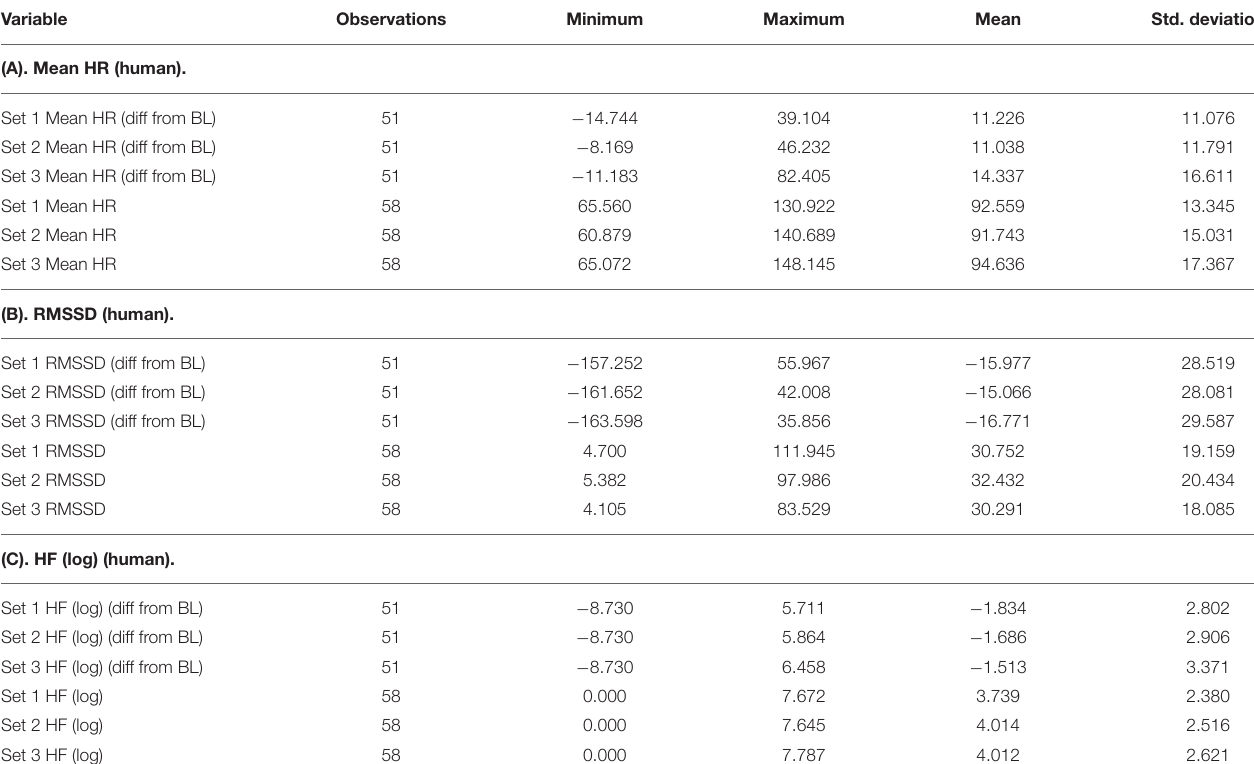
TABLE 4 | Descriptive statistics for the human cardiac activity parameters (raw data, and difference from baseline, BL), by handling set#: (A) mean HR, (B) RMSSD, (C) HF (log). Variable Observations Minimum Maximum Mean Std.